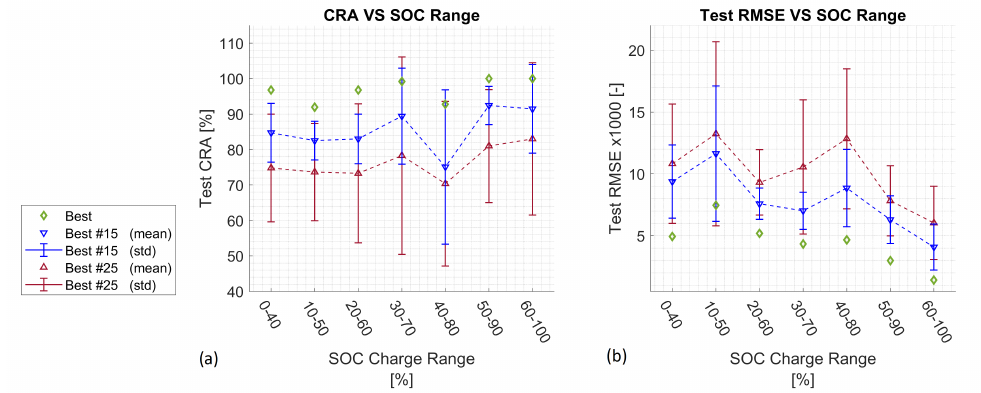
Figure 11. Sensitivity analysis of the best 15 and 25 neural networks according to the RMSE on the testing dataset for L opt = 40%. ( a ) CRA trend depending on the input SOC window selected. ( b ) Test RMSE × 1000 depending on the input SOC window selected.